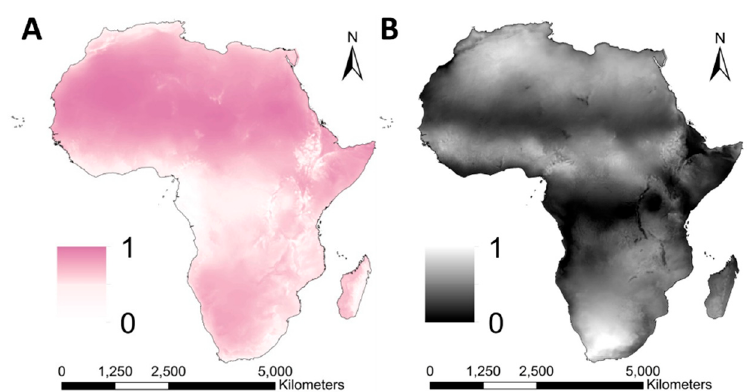
Figure 7. Geospatial variation of the process associated with volatilization; the annual mean ( A ) and standard deviation of the monthly values during the year ( B ). The maps resulted from Equation (8).